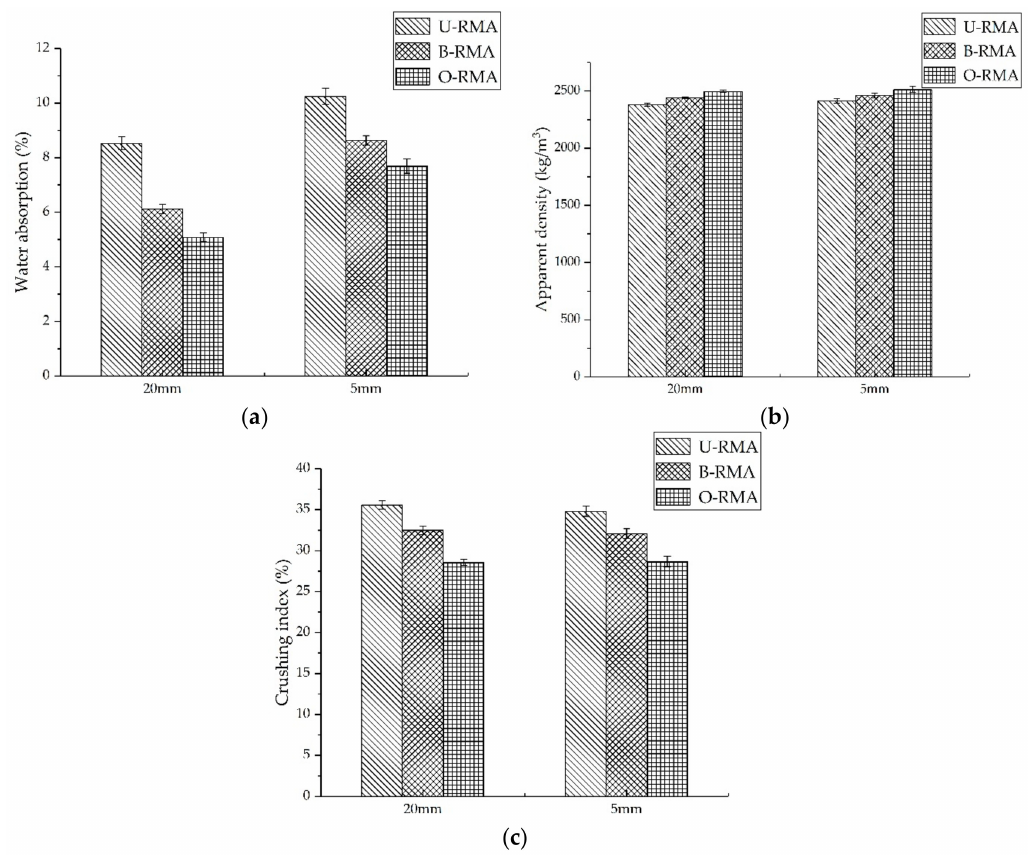
Figure 3. Properties of di ff erent particle RMAs: ( a ) Water absorption; ( b ) Apparent density; ( c ) Crushing